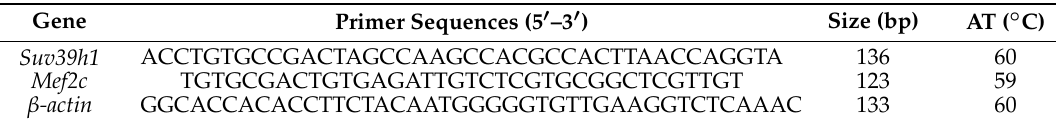
Table 2. The primers for real-time